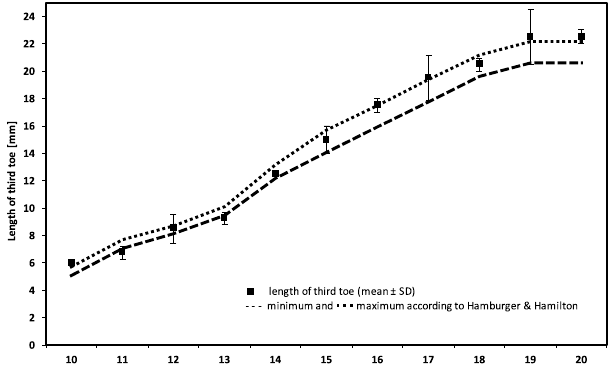
Figure 3. Length of third toe (mm) for chick embryos from Group B in relation to reference values established by Hamburger & Hamilton 7